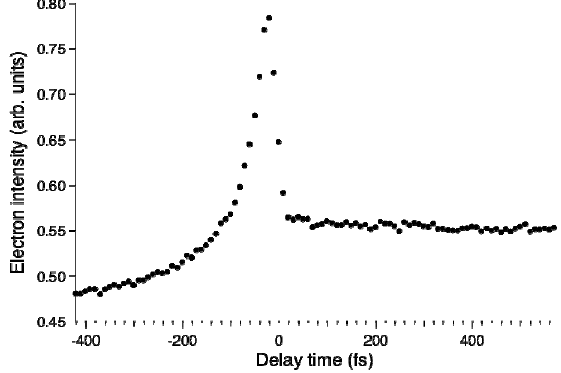
Figure 8. Photoelectron signal time-profile observed for pyrazine using 264 nm pump and 159 nm probe pulses. Negative delay times indicate that the probe pulse precedes the pump pulse.